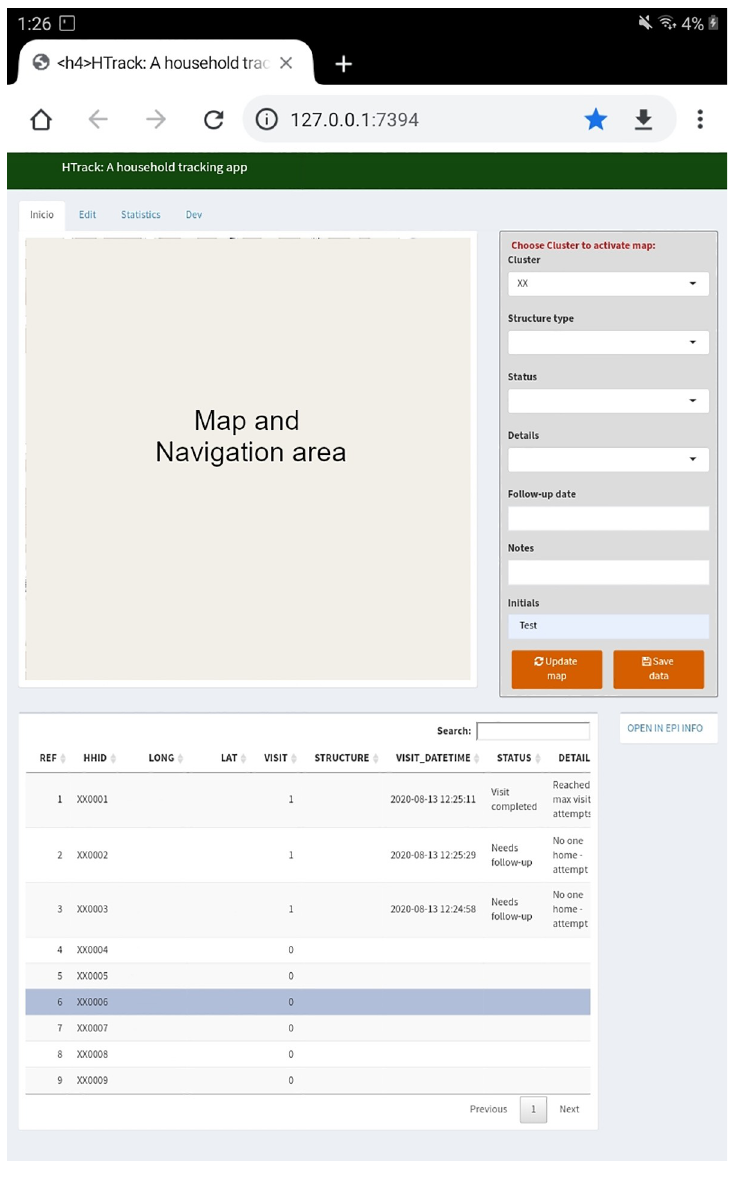
Fig 1. HTrack main tab serves as the general area for site navigation and data entry. This tab incorporates a live map (not shown) with zoom capabilities and a location/navigation toggle (current location appears as a red dot, not shown). The box to the right is the data entry component and is activated by pressing a house marker on the map. The data table below is populated upon data entry and saving. Coordinates are removed from the image to protect participant